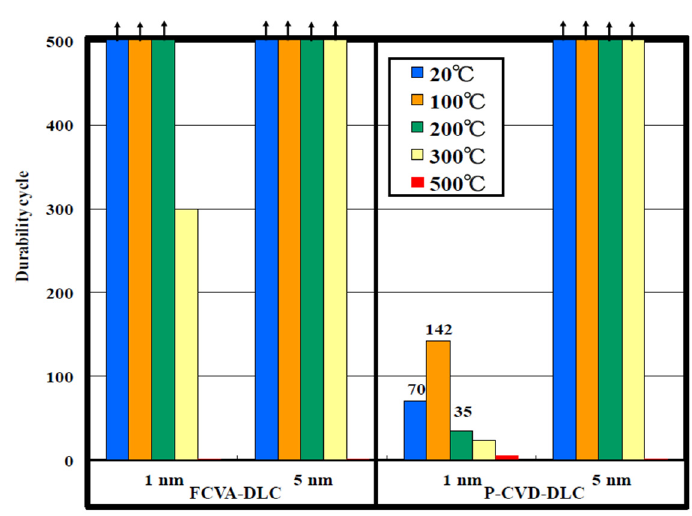
Figure 13. Durability cycles tested at room temperature after heating.